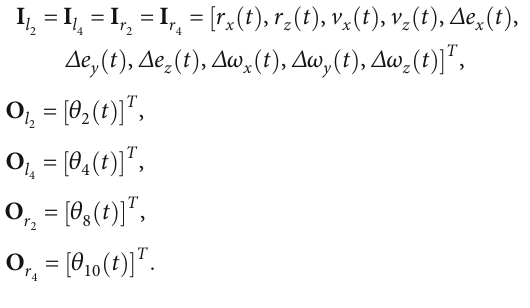
Table 3: Training parameters of the control networks.